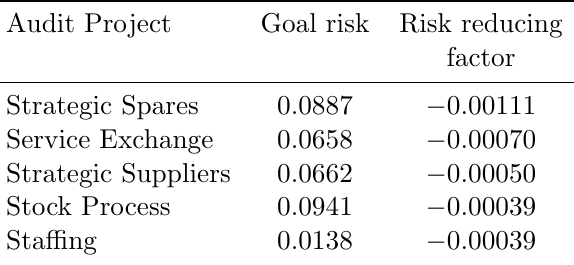
Table 5: Goal risk and risk reducing